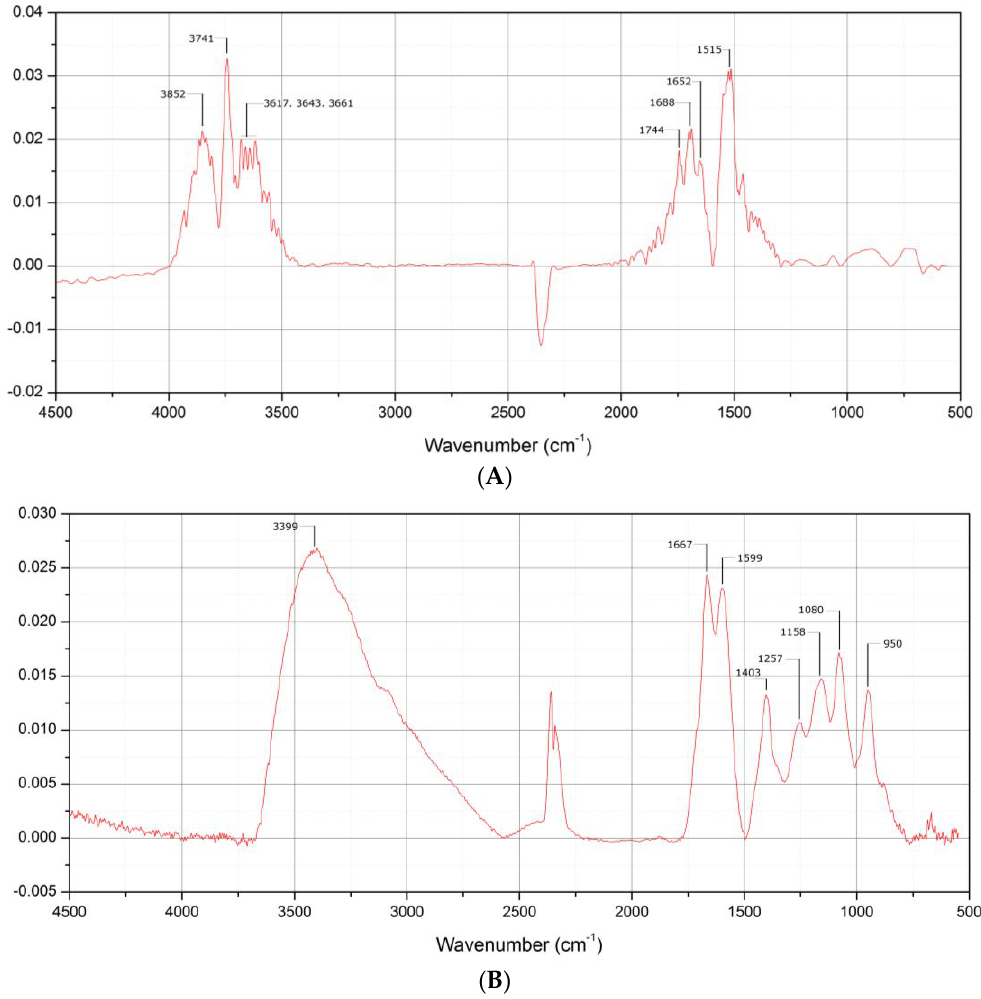
Figure 4. Grazing angle FTIR spectrograms of Au/MPS ( A ) and Au/MPS/PAMAM G4.0-Au ( B ). While in A only non-specific peaks appeared which could not be attributed to the MPS molecule functional groups like S-H or C-S ( A ), Intense absorption bends could be observed from the amine stretching vibration at 3399 which is a cumulative one from primary surface and tertiary amines and amides. Also, absorption could be observed for amine bending vibrations at 1667 and 1599 which is in good agreement to literature data and enough for identification of the